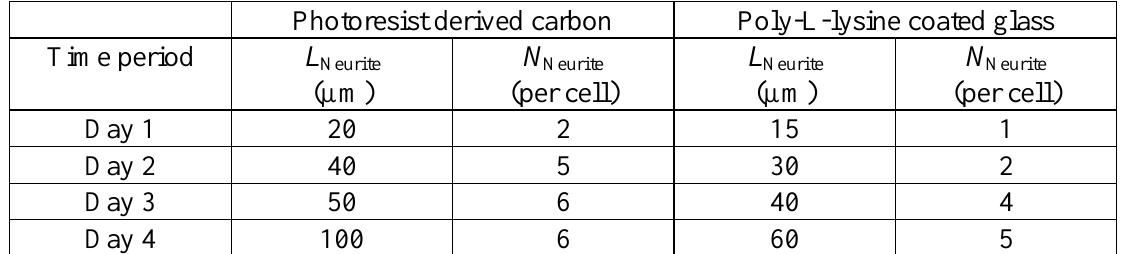
Table 1. Average values for measurements of neurite growth for differentiated PC12 cells cultured on Photoresist derived carbon and Poly-l-Lysine coated glass